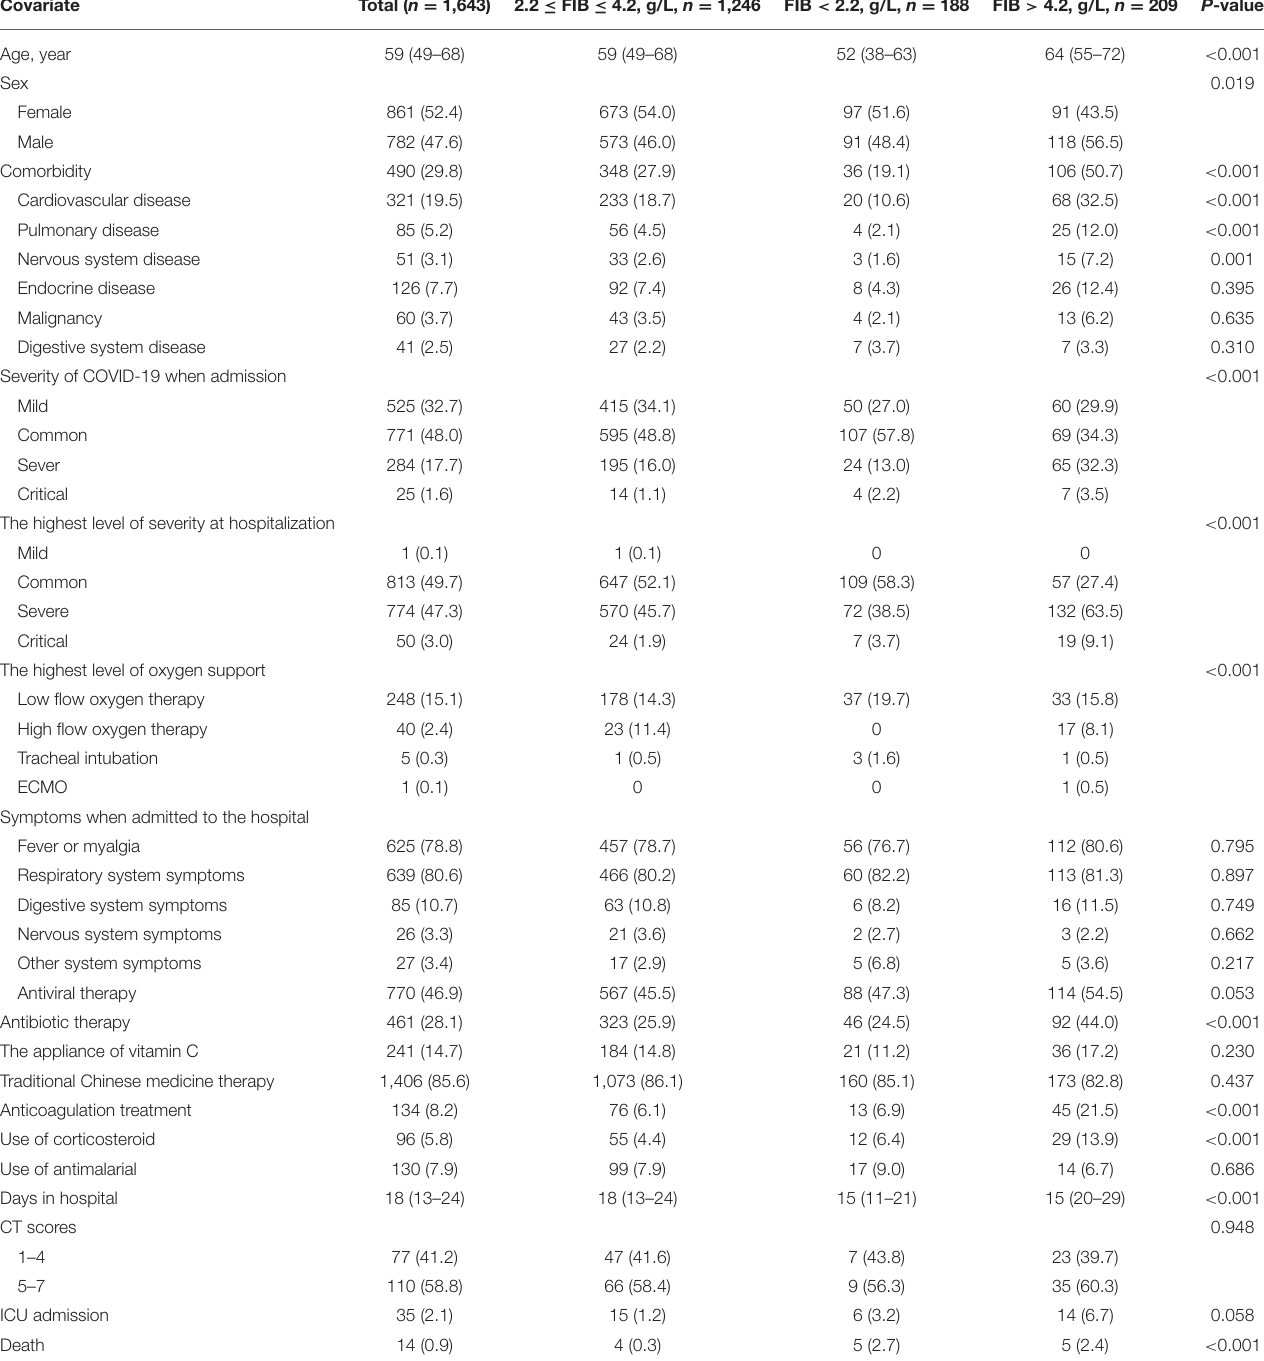
TABLE 1 | Demographic and clinical features of 1643 patients with COVID-19.